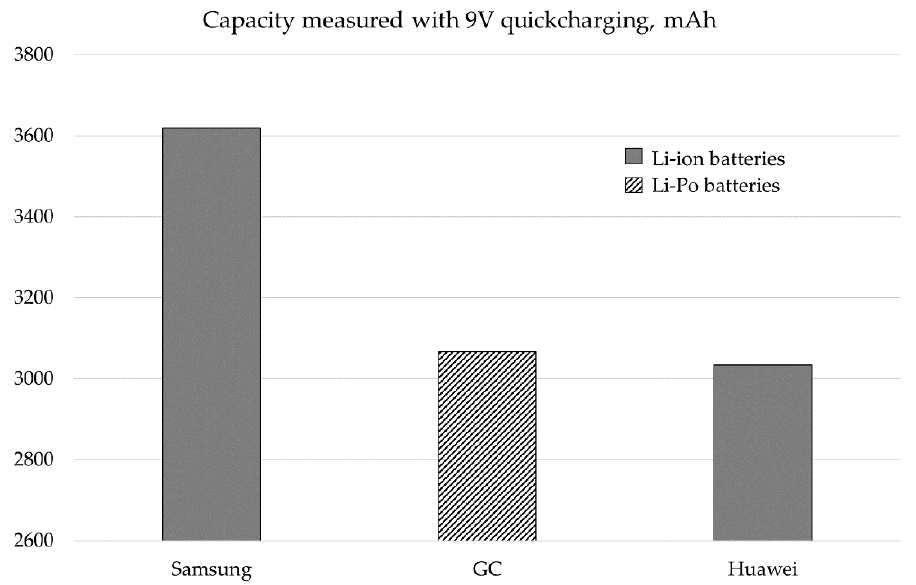
Figure 9. Capacity in mAh measured with 9 V quick charging for power banks offering such a function.